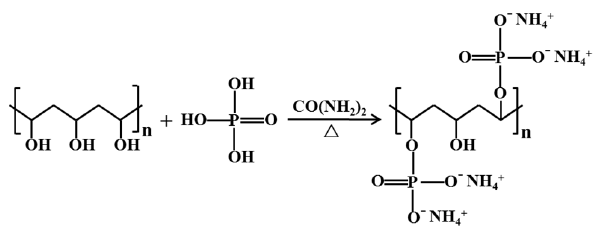
Figure 1. Schematic diagram of the synthesis of ammonium alcohol polyvinyl phosphate (AAPP).